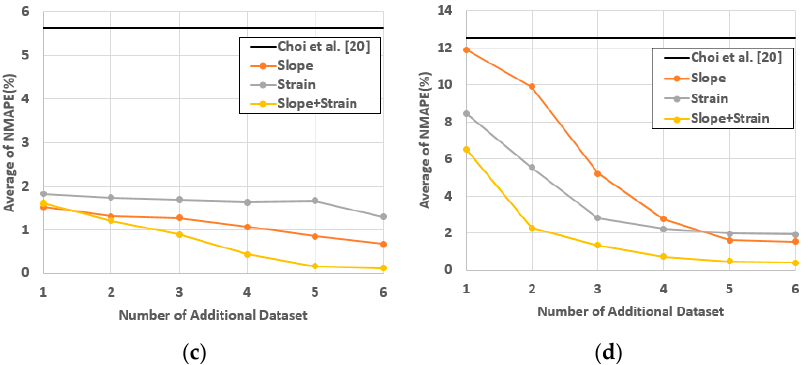
Figure 24. Mean NMAPE for displacement by additional response data: ( a ) RDS1, ( b ) RDS2, ( c ) RDS3, ( d ) RDS4.